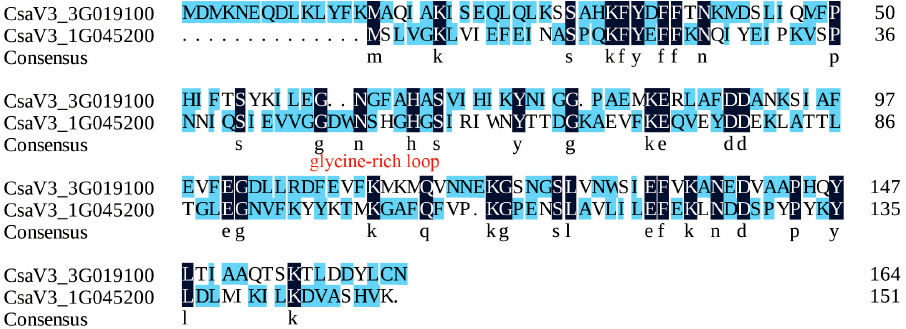
Figure 6. Sequence analysis to CsaV3_1G045200 (CsMLP1) and CsaV3_3G019100 (CsMLP5) in cucumber. The conserved Gly-rich loop of the MLP protein was marked in red. Amino acid residues conserved in two proteins are black shaded.